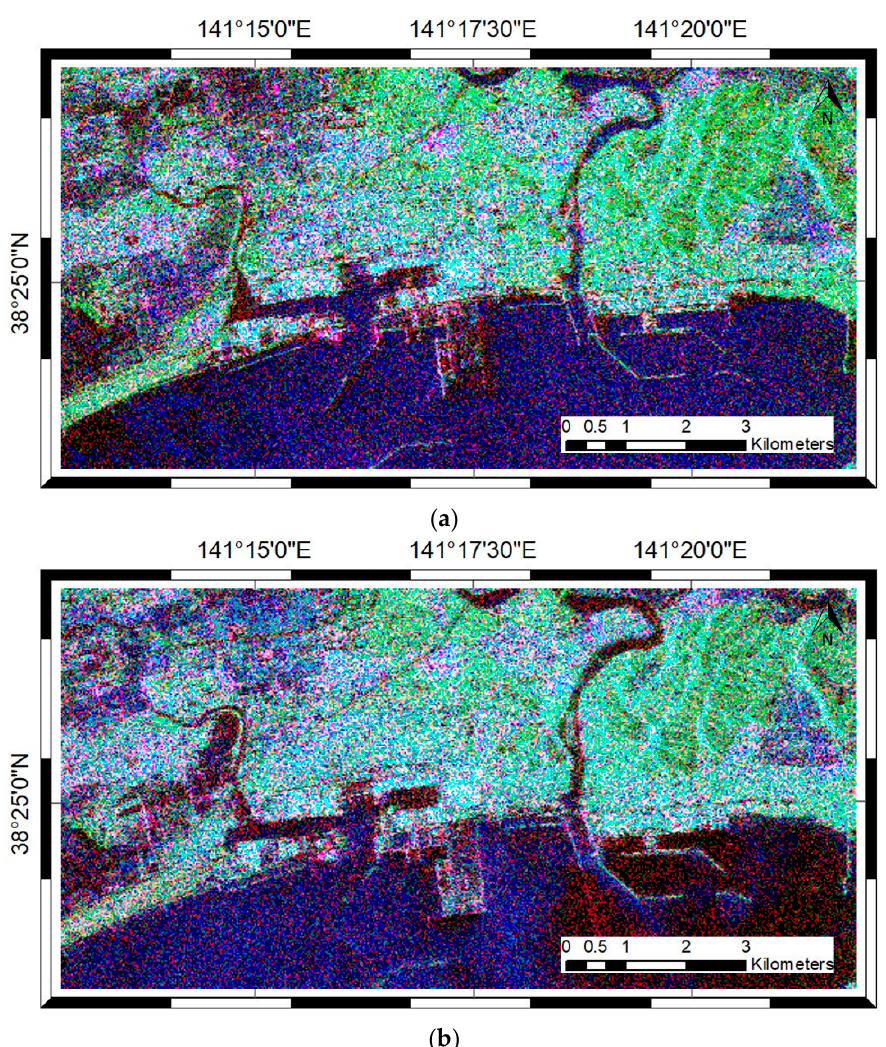
Figure 5. Pauli RGB images of ( a ) ALOS/PALSAR-1 on April 2, 2009; and ( b ) ALOS/PALSAR-1 on 8 April 2011. | S hh − S vv | , | S hv | , and | S hh + S vv | are assigned to the Pauli RGB channel.